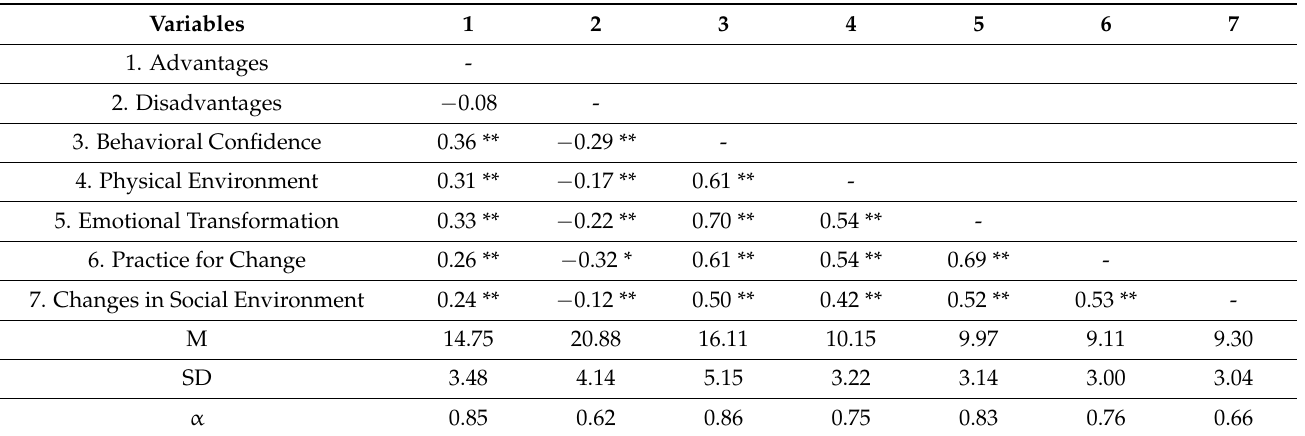
Table 3. Summary of bivariate correlations, means, standard deviations, and internal consistency estimates for the study